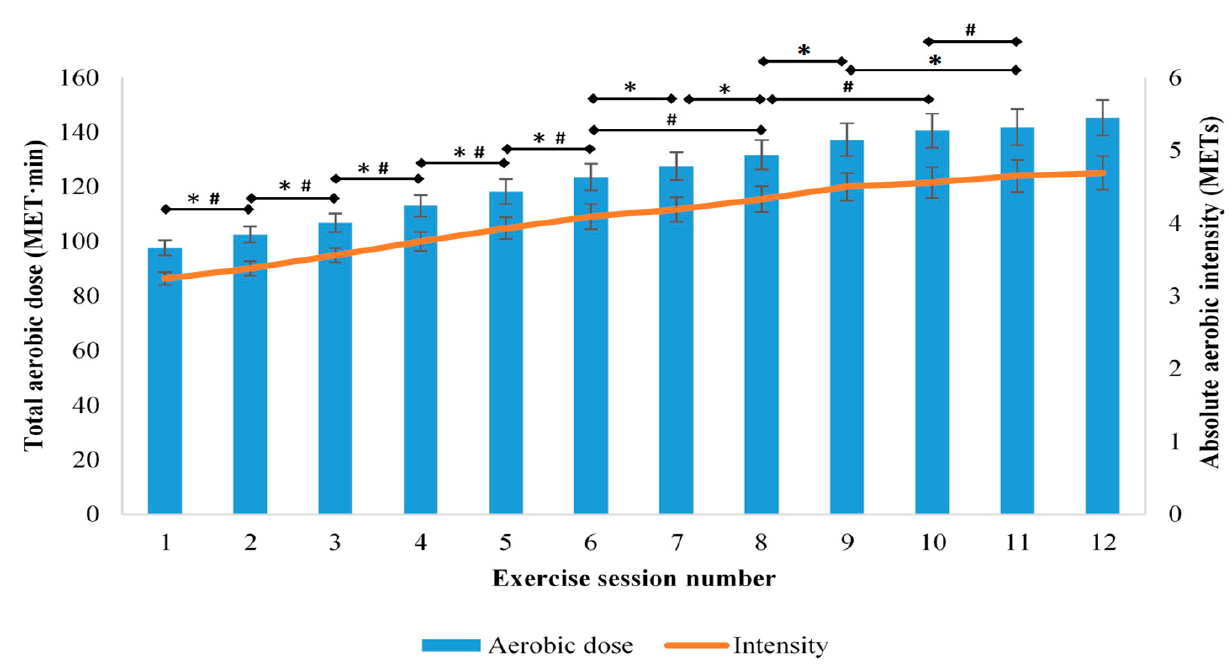
Figure 1. Aerobic exercise training prescription during 12 sessions of cardiac rehabilitation. Data presented as mean (95% CI). * Significant progression in total exercise dose, # significant progression in absolute aerobic intensity. METs—metabolic equivalents.